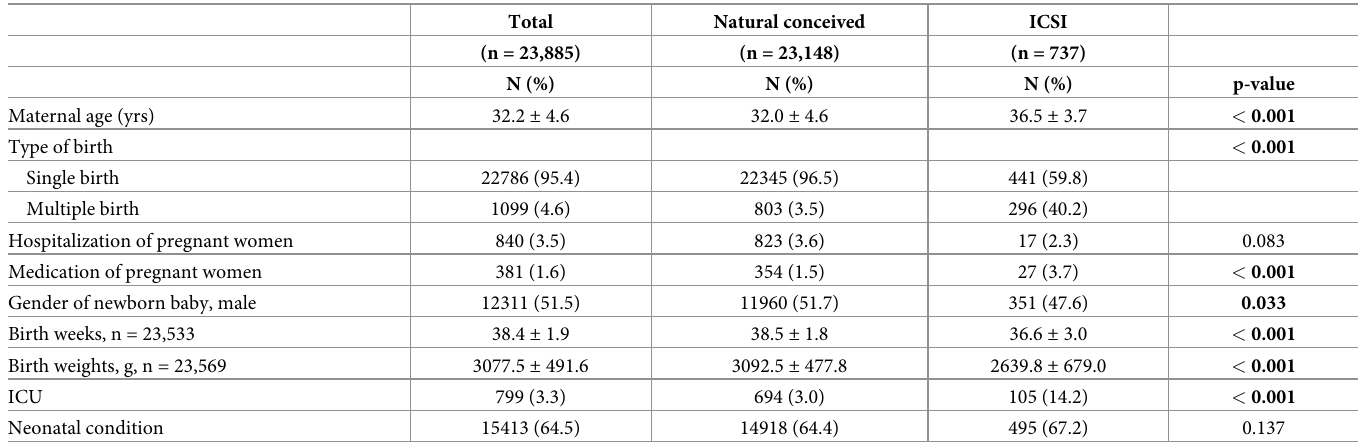
Table 1. Original characteristics of pregnant women and newborn baby in the study